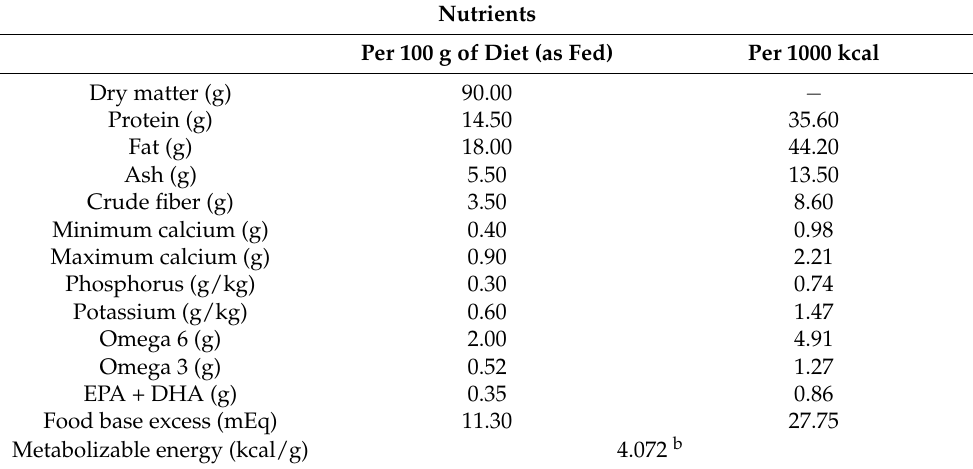
Table 1. Diet composition a as fed and per 1000 kcal and ingredients * according to the manufacturer of the renal diet used in the study .